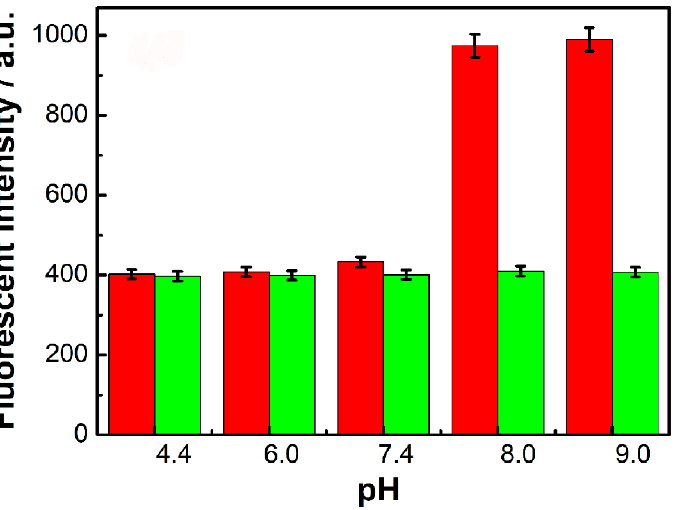
Figure 6. The effect of pH on the detection of ClO − . Red columns represent the fluorescence inten- sity of the probe; green columns represent the fluorescence intensity of the mixed solution after adding ClO − . c (probe, μ L): 20; c (ClO − , μ M): 50; 40 mM phosphate buffer solution: pH 8.0. λ ex : 285 ClO − . c (probe, µ L): 20; c (ClO − , µ M): 50; 40 mM phosphate buffer solution: pH 8.0. λ ex : 285 nm; nm; λ em : 460 nm; all the error bars represent the standard deviation of three measurements. λ em : 460 nm; all the error bars represent the standard deviation of three